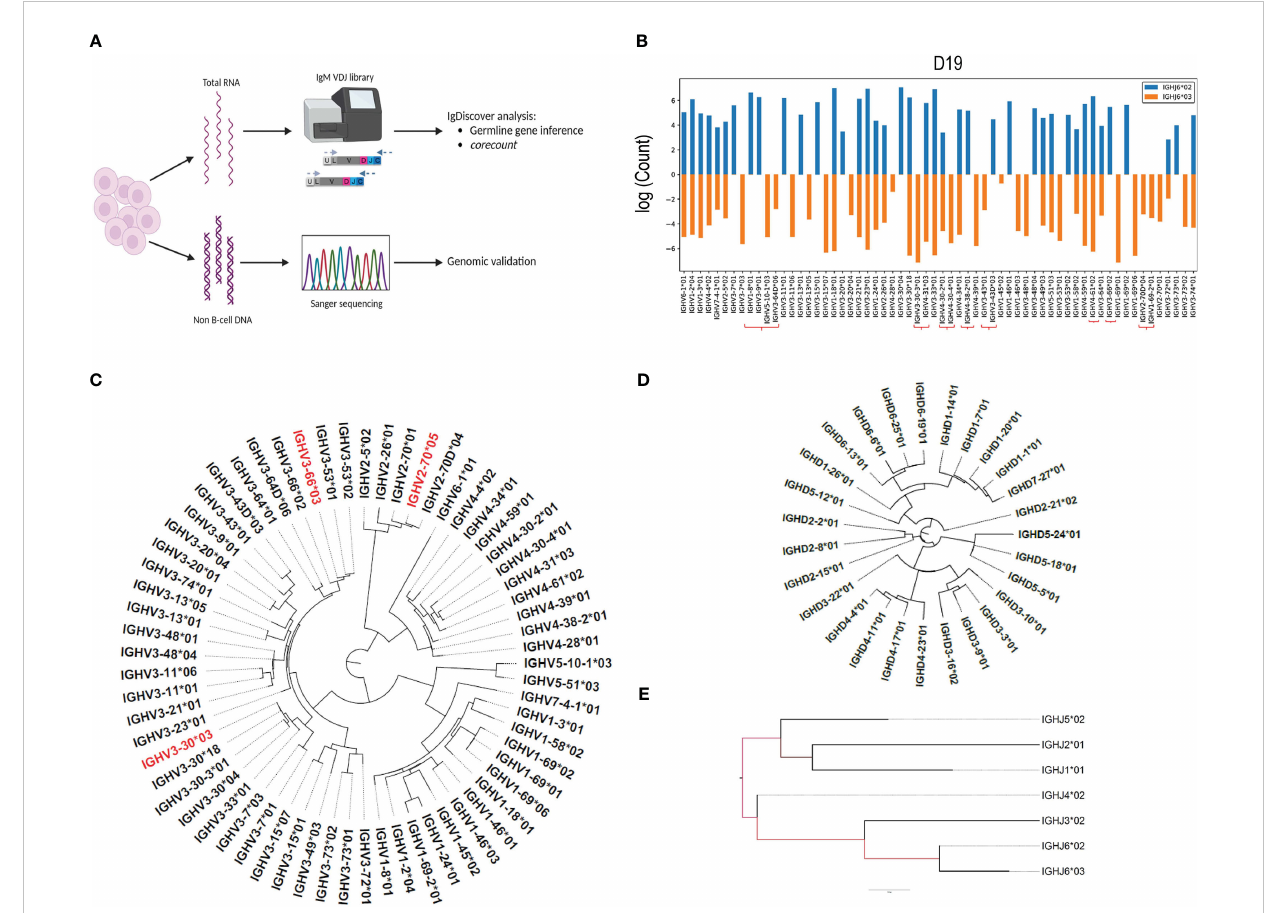
FIGURE 1 IgM library preparation and inferred genotype. (A) Peripheral blood samples separated into polymorphonuclear and mononuclear cell fractions, with DNA and RNA extracted from each fraction respectively. IgM libraries were prepared from the RNA fraction, sequenced using the Illumina MiSeq system, and analyzed for the presence of novel alleles using the IgDiscover program. Genotyping was subsequently performed using the corecount module. DNA isolated from the polymorphonuclear fraction was used as template for genomic PCR of individual V, D and J alleles and subsequent Sanger validation. (B) Inferred haplotype analysis of case D19. IgDiscover plotallele output using IGHJ6*02 and IGHJ6*03 as haplotyping anchors. Genes associated with common structural alterations are marked with the red brackets. Dendrograms of (C) , Sanger validated IGHV alleles,